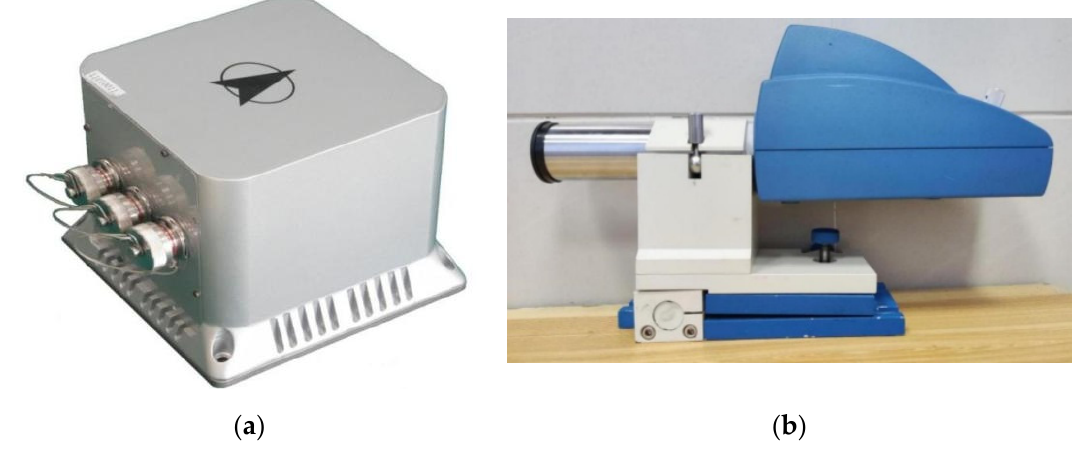
Figure 10. ( a ) IMU; ( b ) electronic autocollimator.